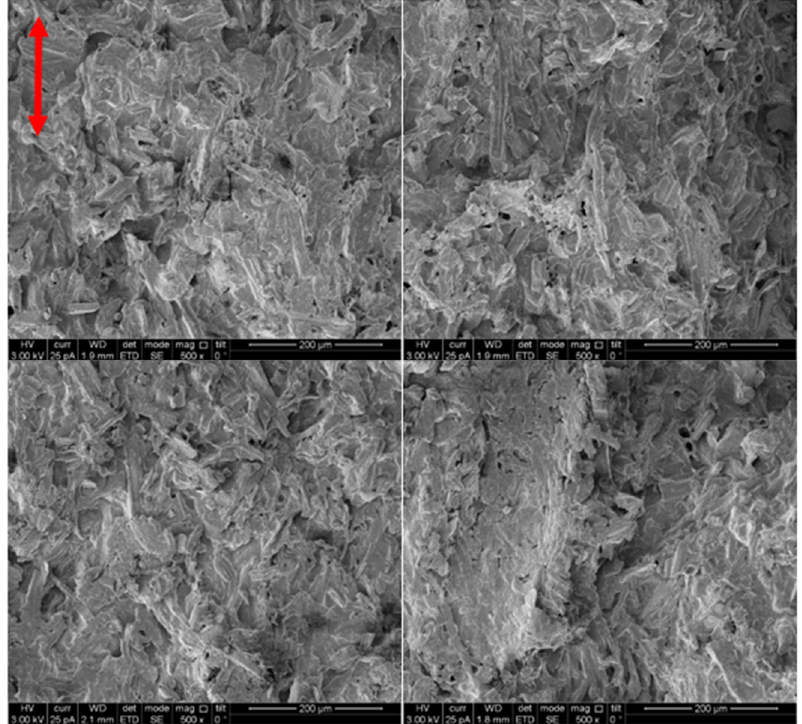
→ ⃗ = 1500 mm min ⁄ v = 1500mm/min (arrows indicating ⃗ = 1500 mm min ⁄ (arrows indicating (arrows indicating